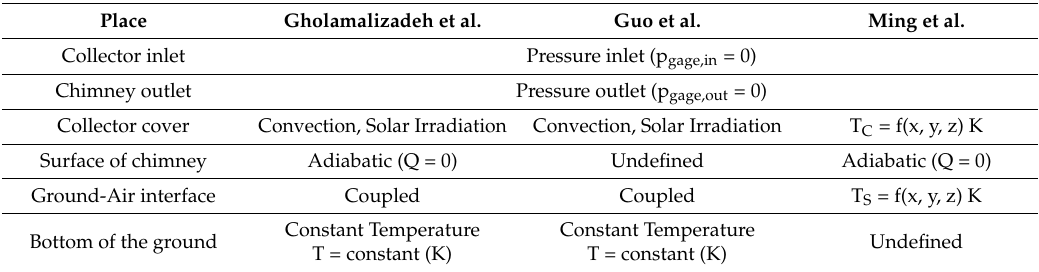
Table 4. Boundary conditions.